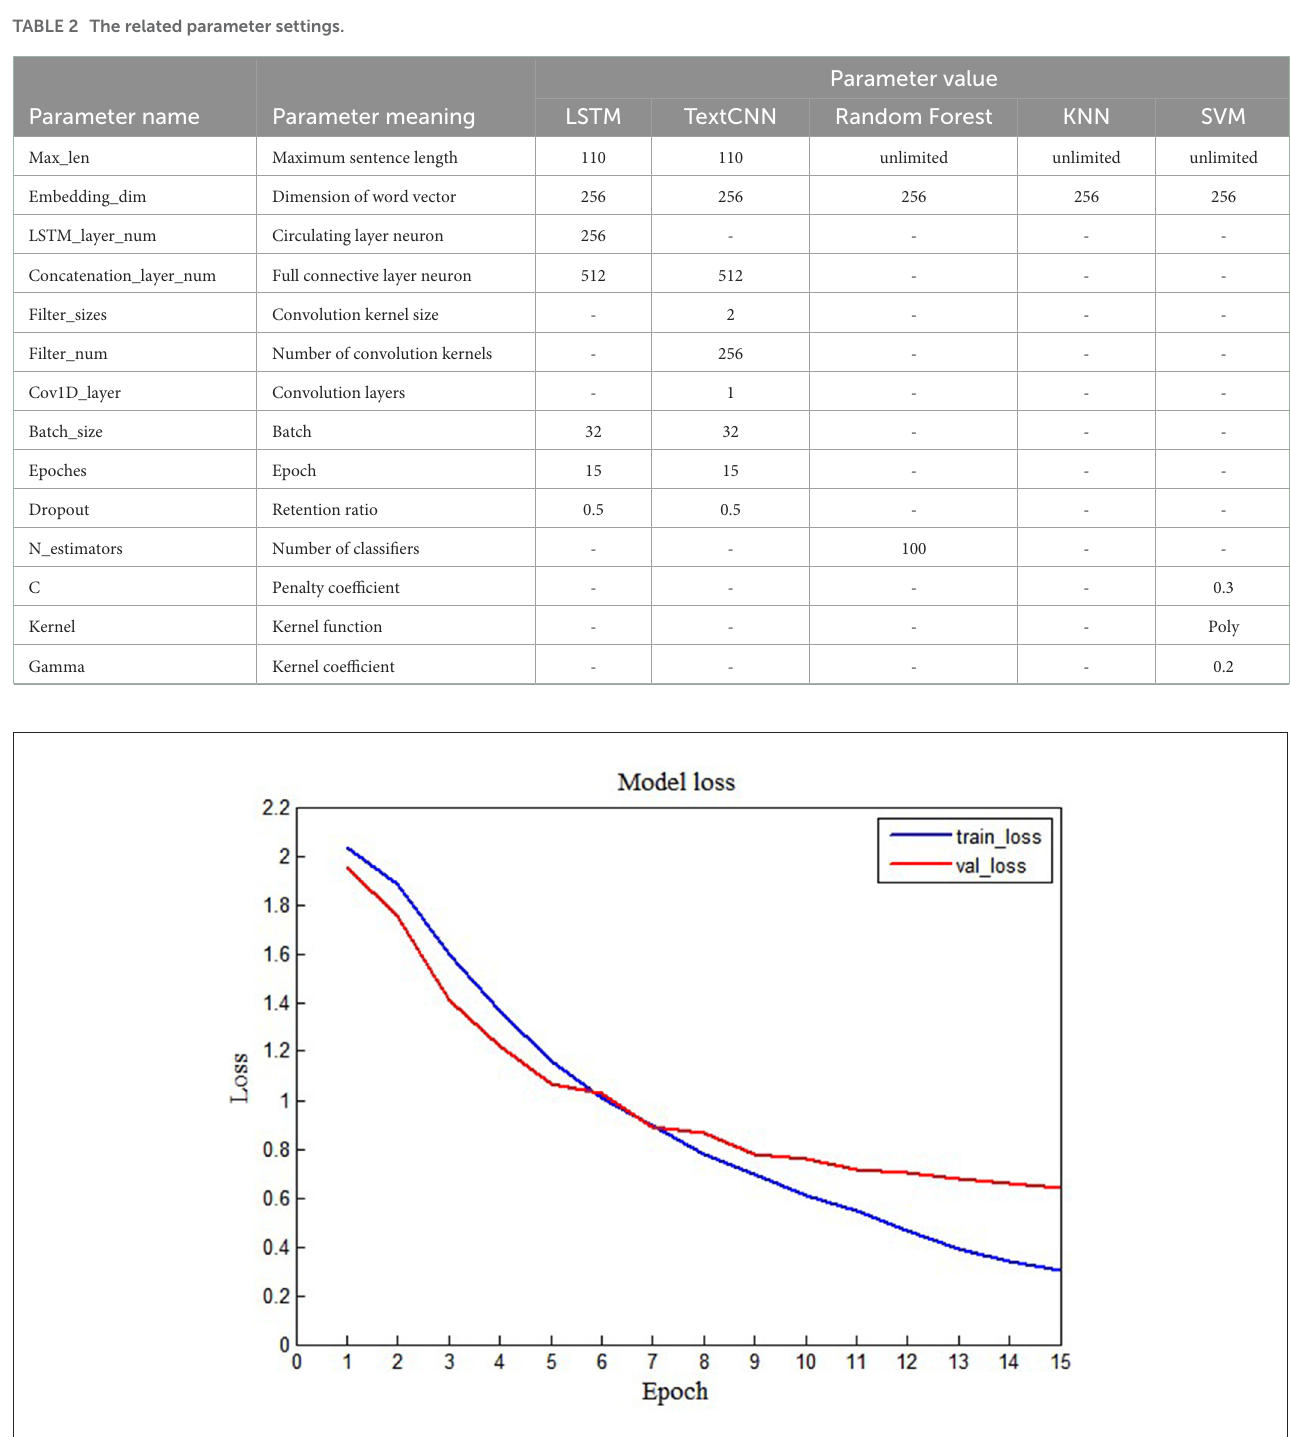
FIGURE7 The training loss and validation loss of the LSTM